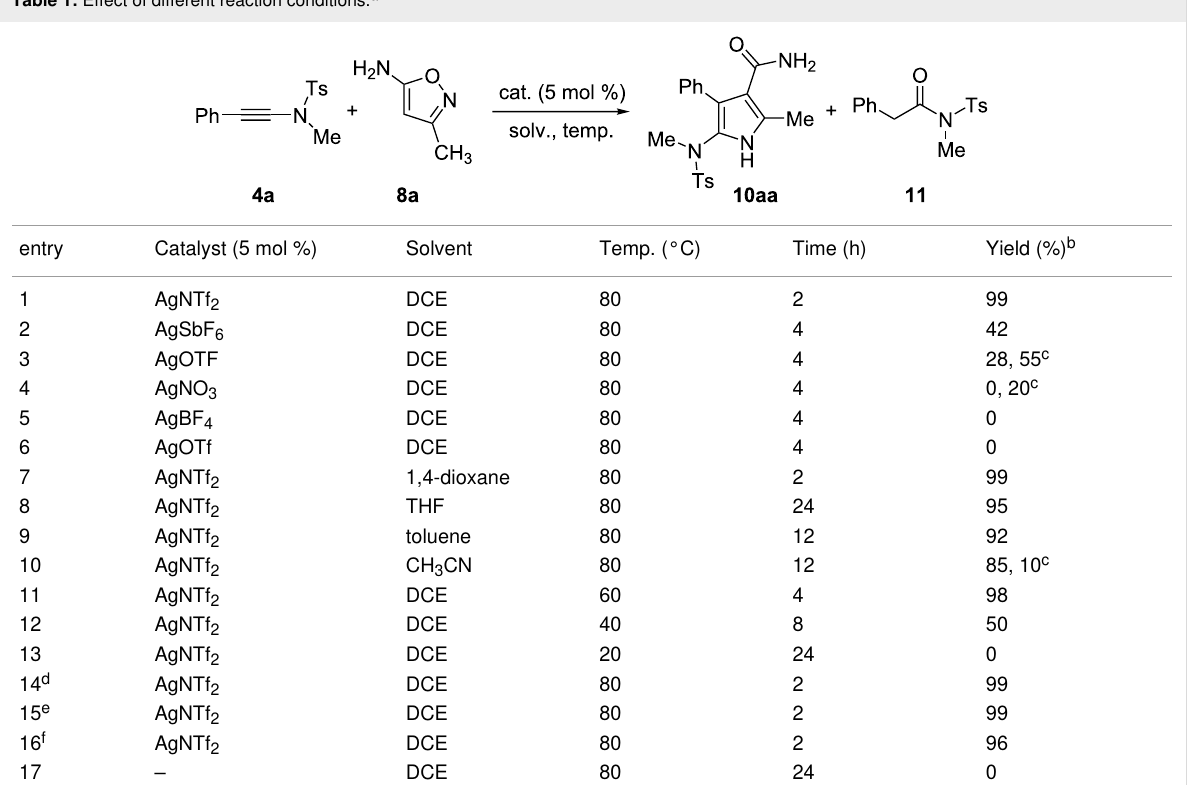
Table 1: Effect of different reaction conditions.